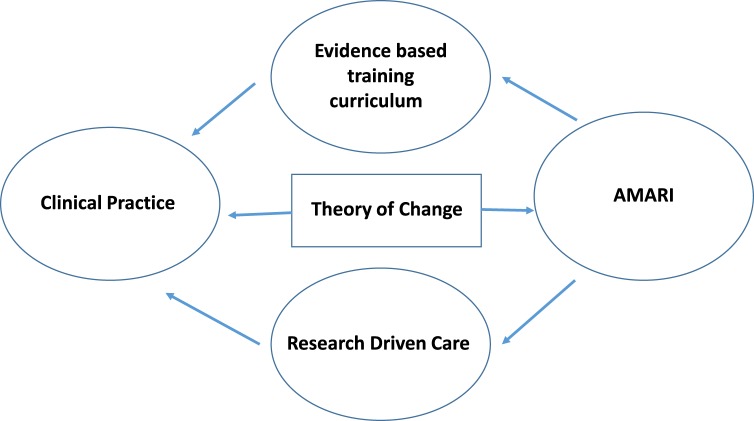
AMARI future role.